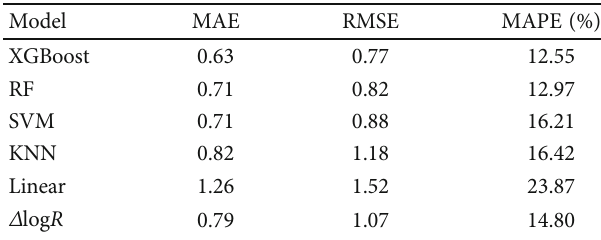
Figure 9: MAPE results of the 5-fold cross-validation. Table 2: Mean error values of di ff erent methods for 5-fold